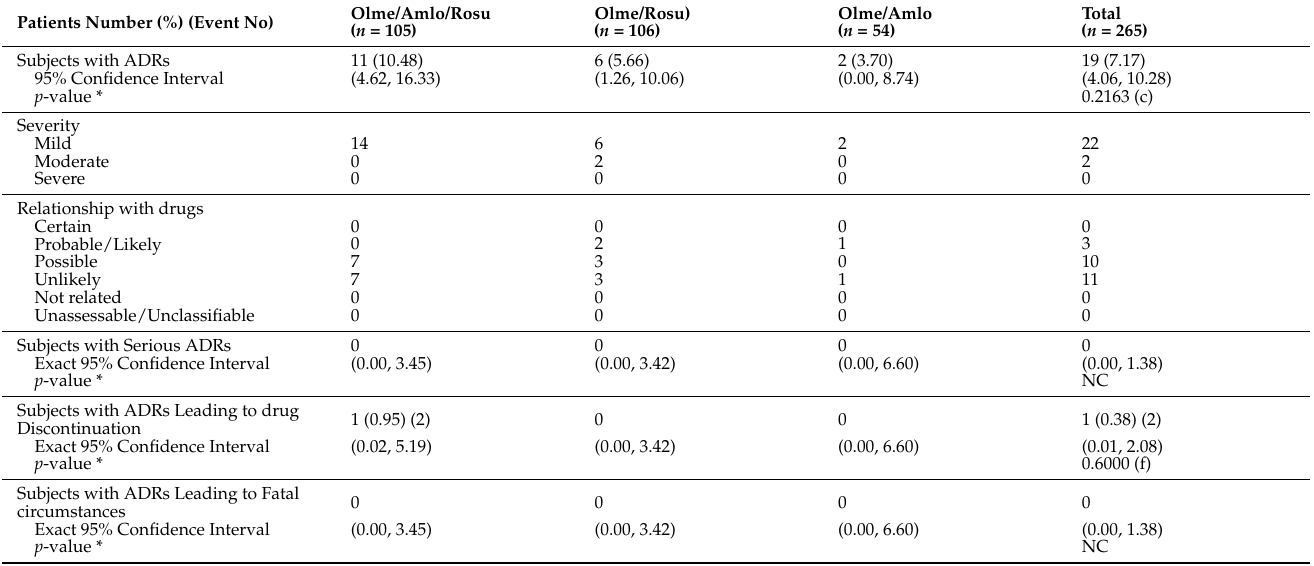
Table 4. Adverse drug